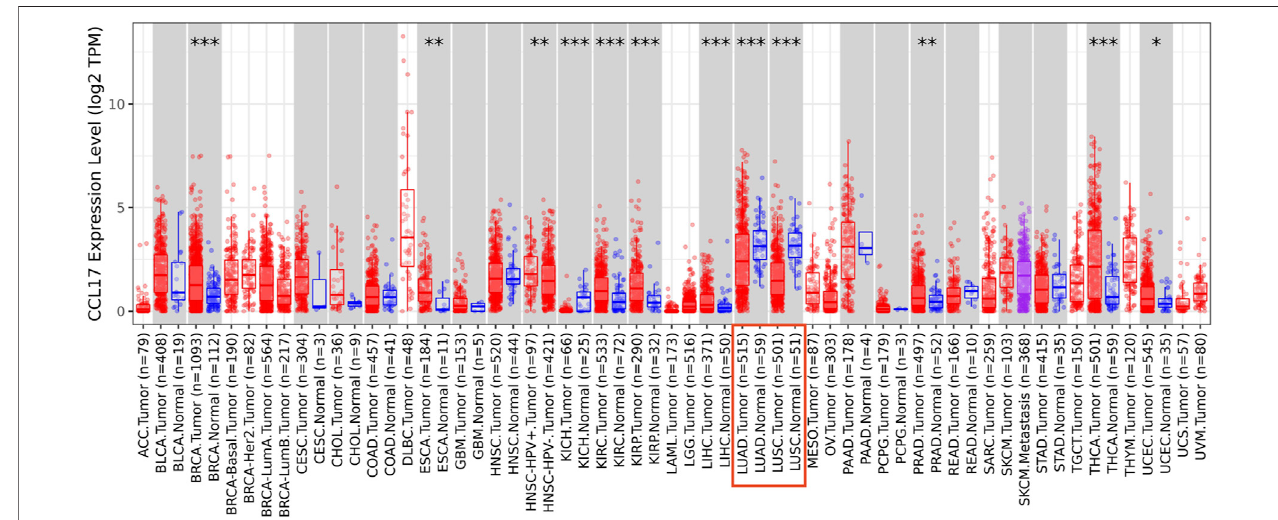
FIGURE 2 | Difference of CCL17 expression levels in LUAD and LUSC in TIMER (* p < 0.05, ** p < 0.01, *** p < 0.001).